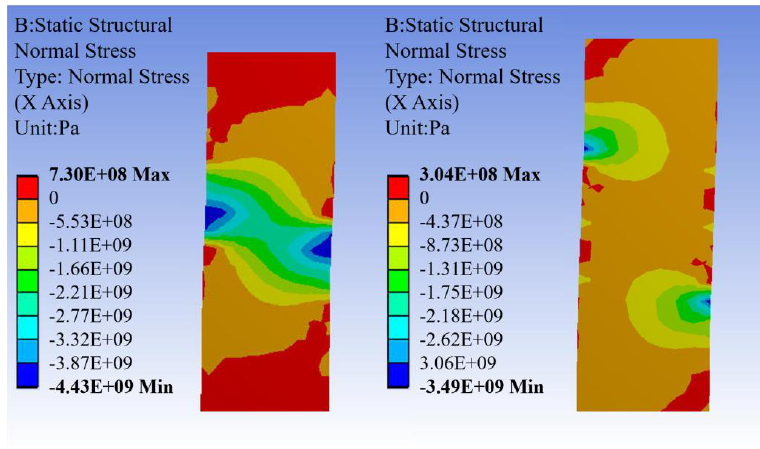
Figure 21. Stress analysis for comparison of the screws (normal stress).